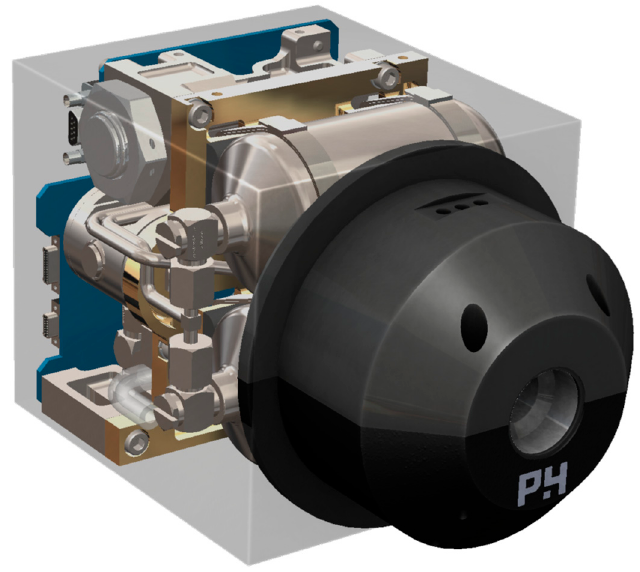
Figure 18. Phase Four RF Thruster [38].